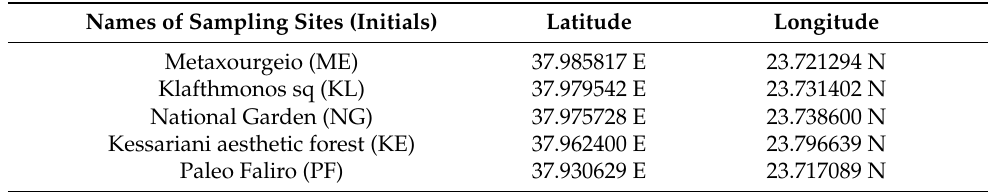
Figure 2. ( a ) Map of Attiki county and Athens metropolitan area, which is located southwest of the mainland of Greece (in the insert); the yellow square indicates the wider location of the sampling sites. ( b ) The five sampling sites indicated by yellow initials; four of them (PF, NG, KL and ME) are within the urban fabric, while KE is on the slope of Hymettus mountain.